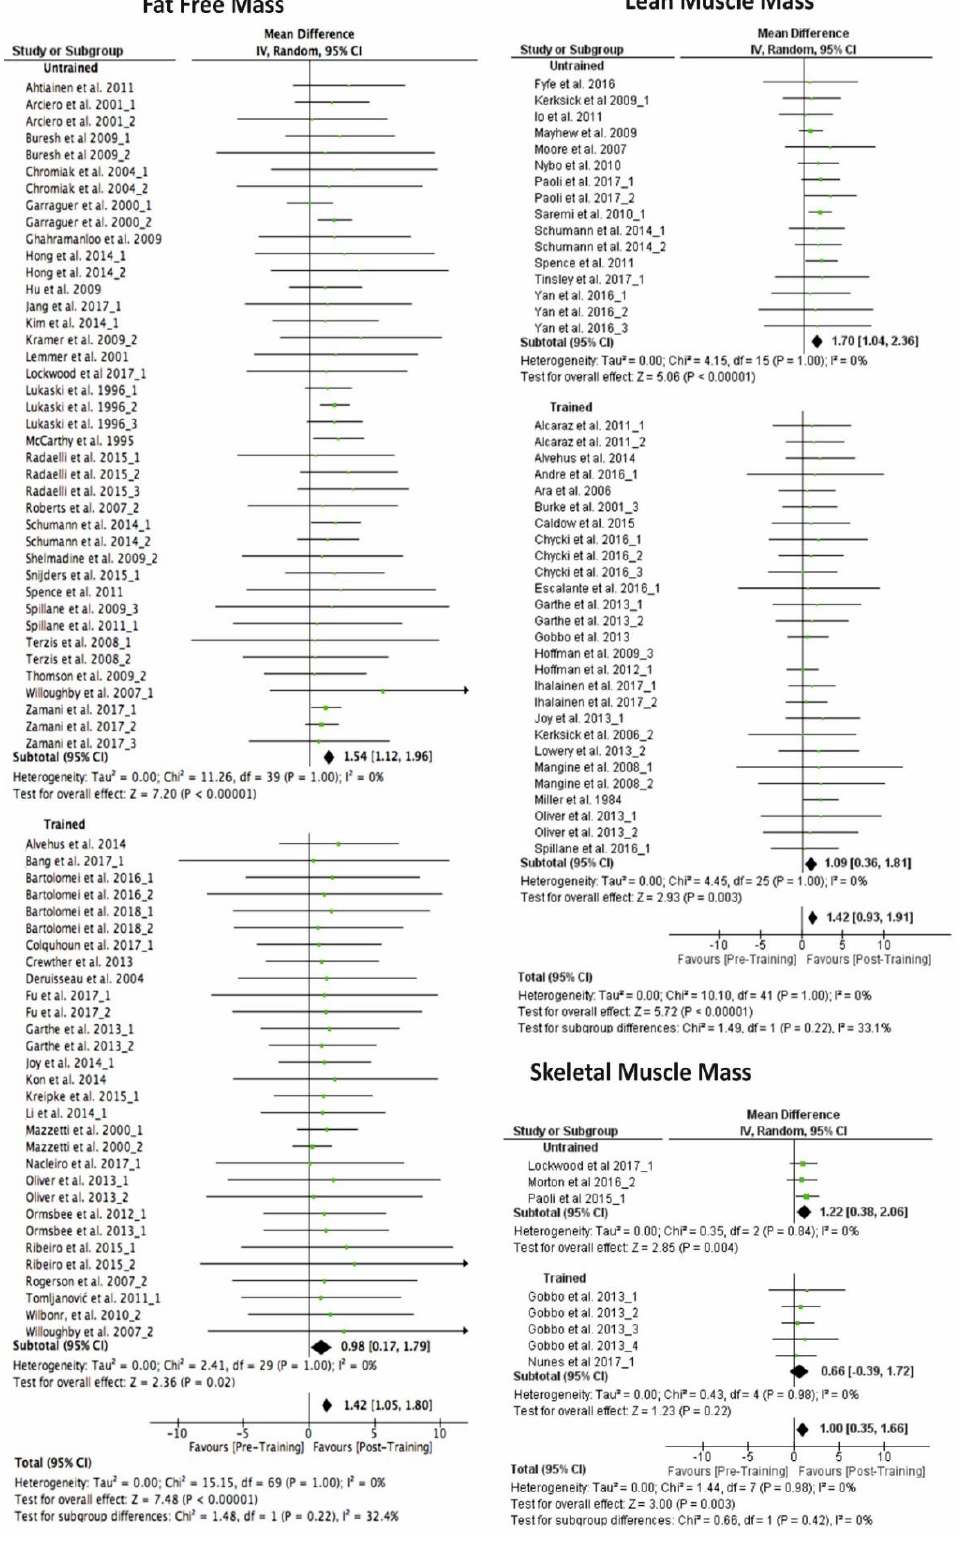
Figure 3. Mean di ff erences exploration comparing the training e ff Figure 3. Mean differences exploration comparing the training effect.